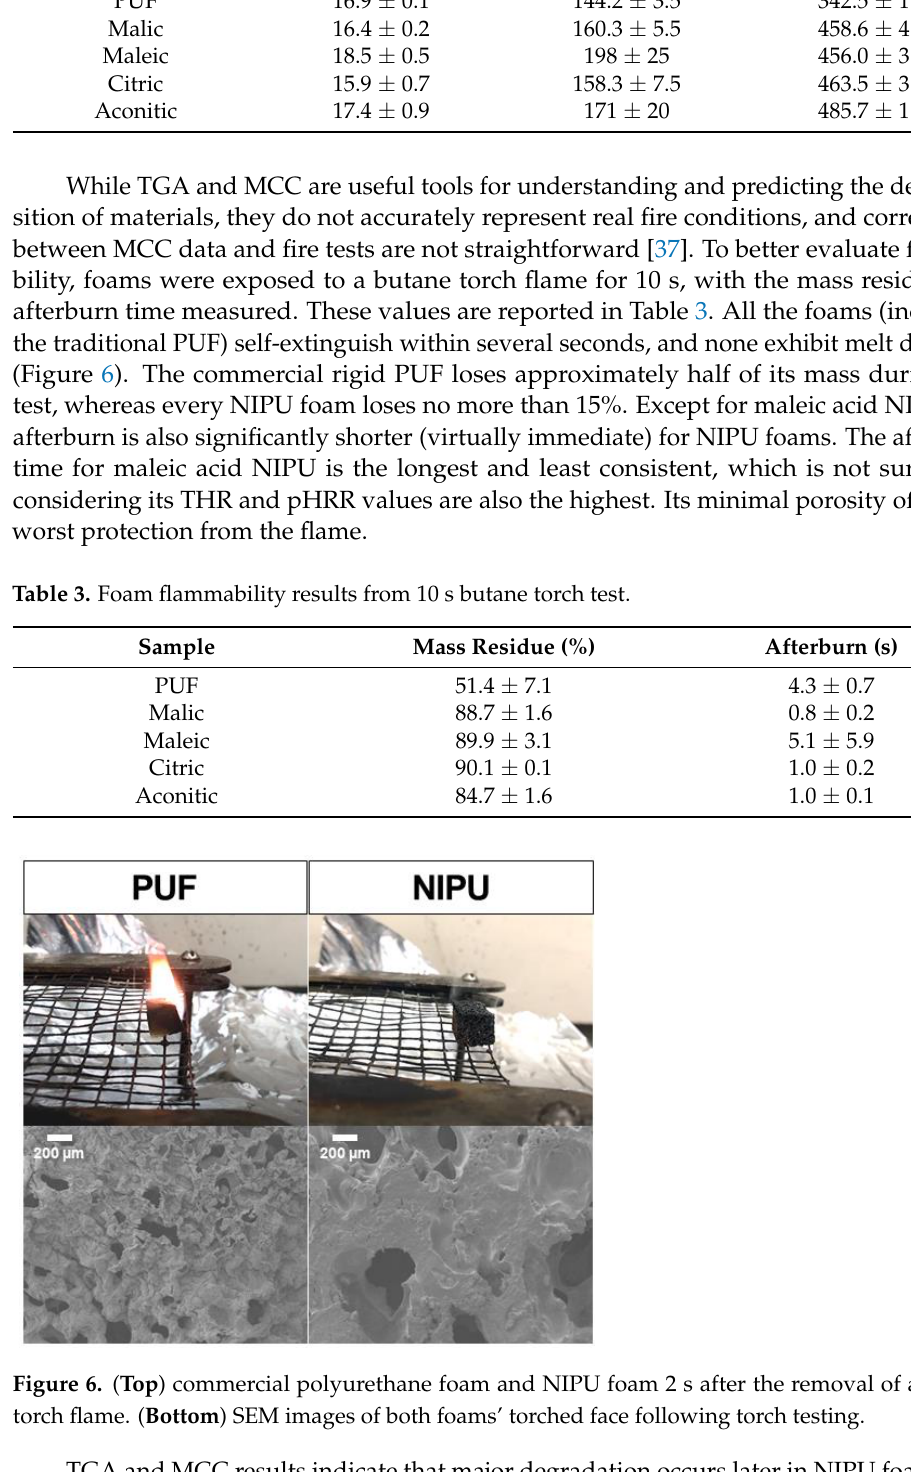
Table 2. Microscale combustion calorimetry parameters for each foam sample.